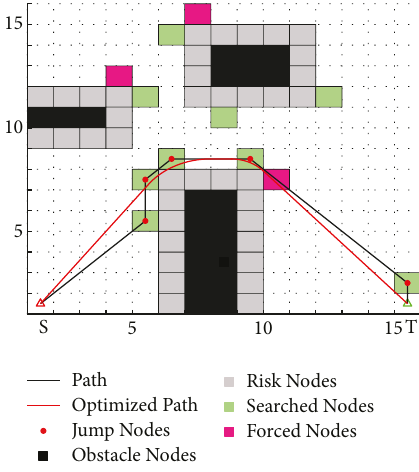
Figure 9: Adaptive arc